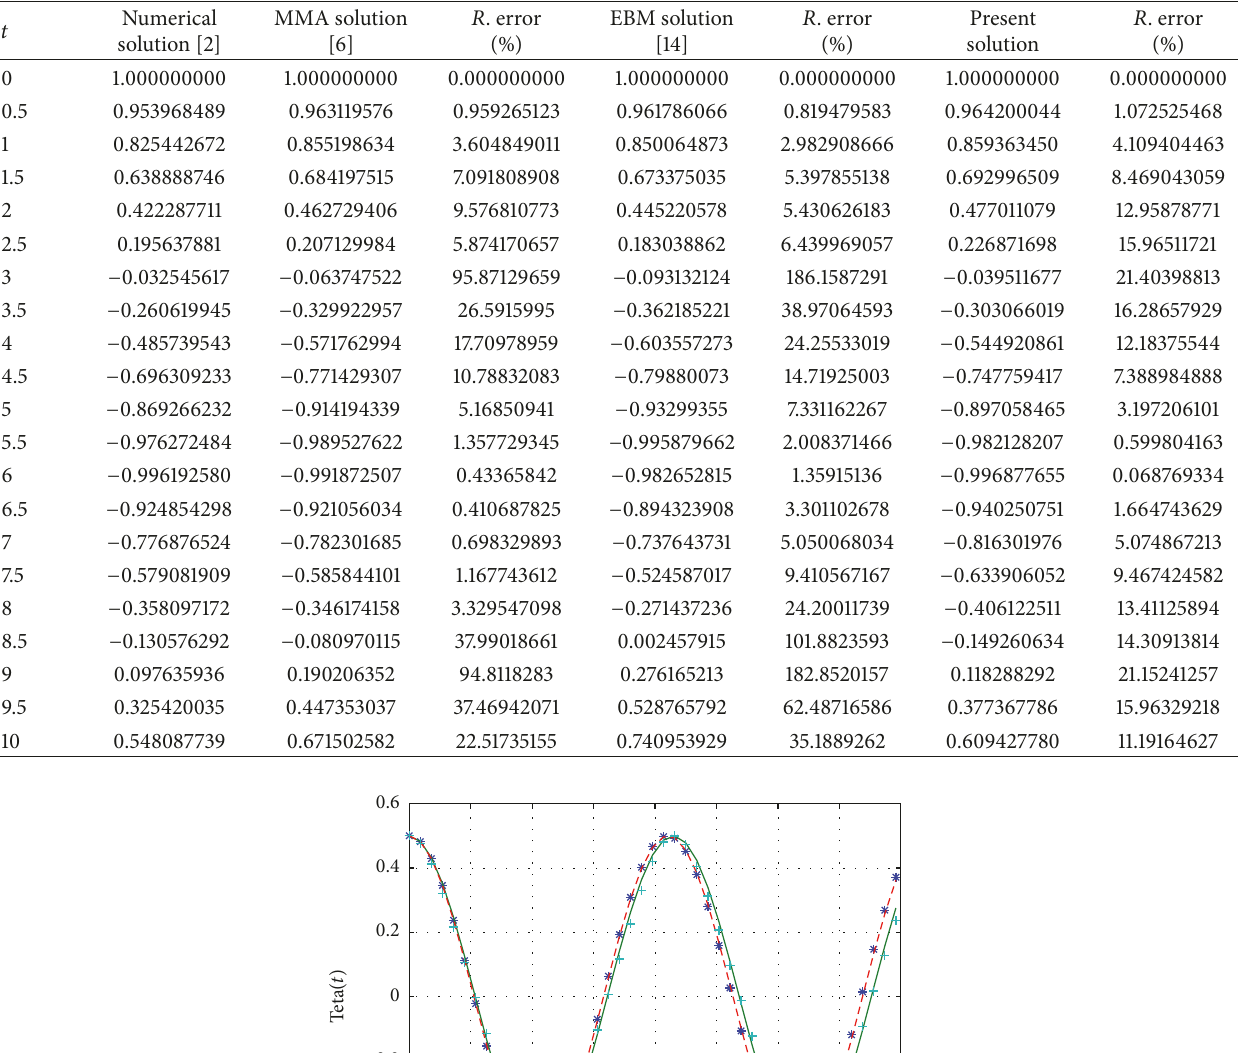
Table 3: The results of present, approximate obtained by Jouybari & Ramzani, and numerical solution for 𝜃(𝑡) when Λ = 1 and 𝐴 = 1 , Example 2.